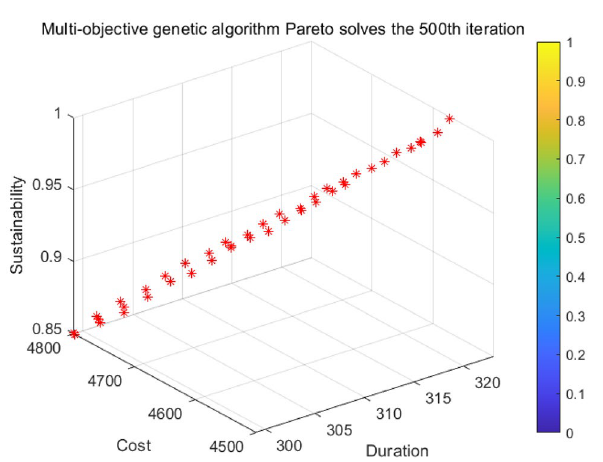
Figure 5. Schedule-cost-sustainable Pareto